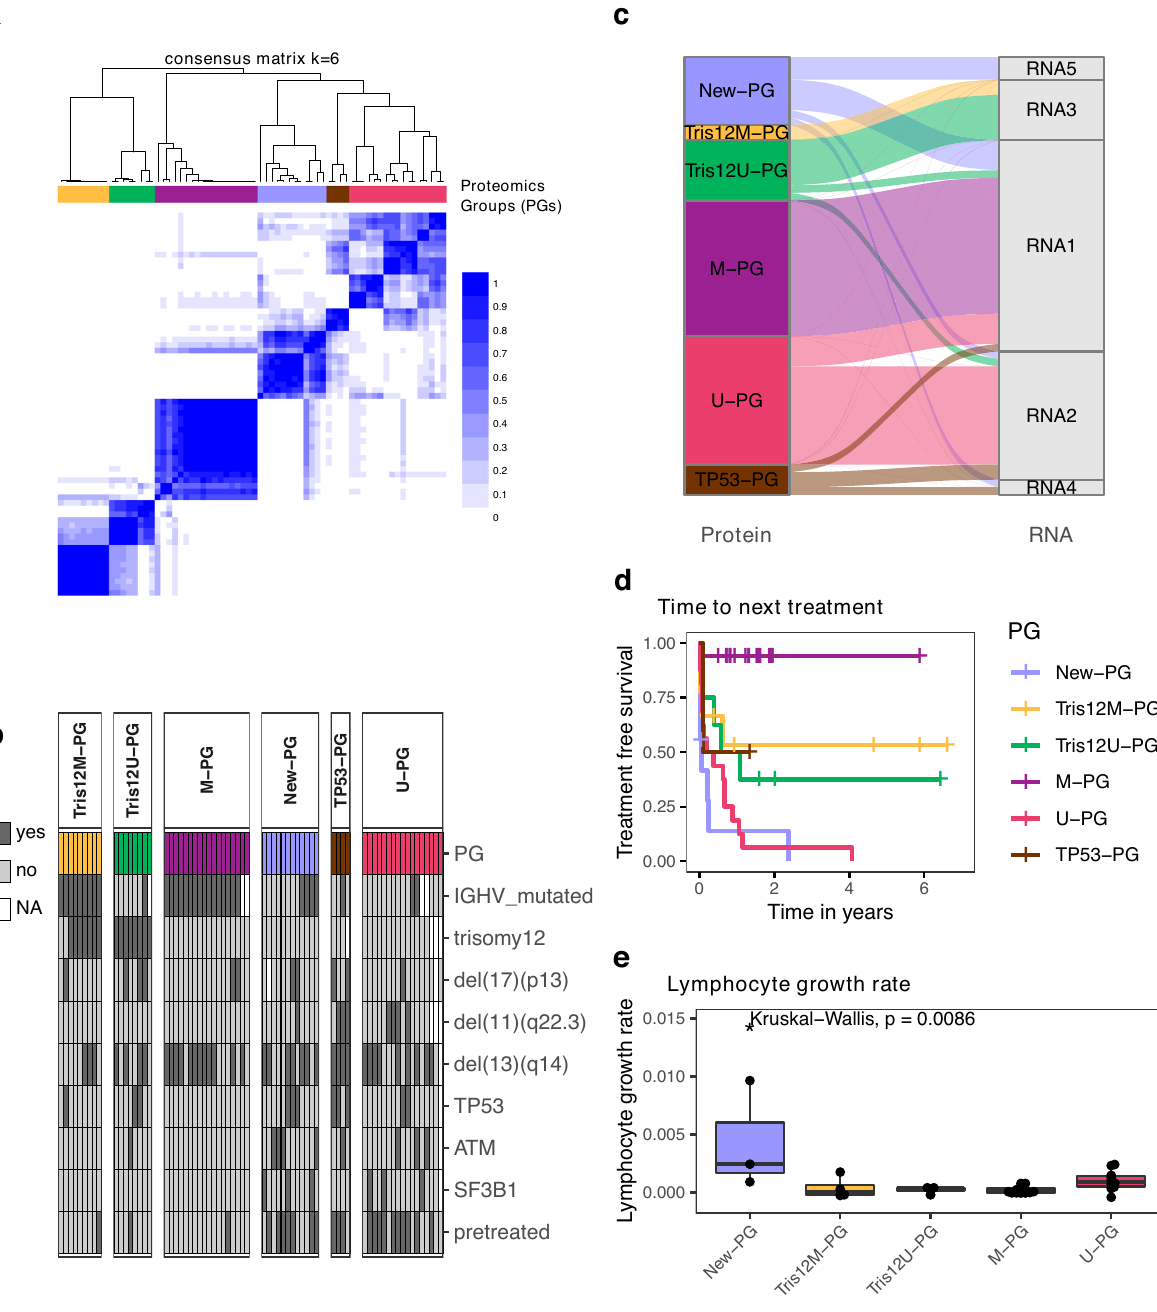
Fig. 4 | Consensus clustering of proteomics pro fi les partitioned CLL into six subgroups. a Consensus clustering partitioned CLL samples into six proteomics groups (PGs). The color scale indicates which proportion of iterations patients clustered together. b Annotation of PGs with genetic alterations and pretreatment status. c Comparison of proteomic-based with transcriptomic-based consensus clustering. n =58 biologically independent samples. d The PGs had signi fi cantly different times to next treatment (TTNT; log-rank test, p <0.0001). Only patients